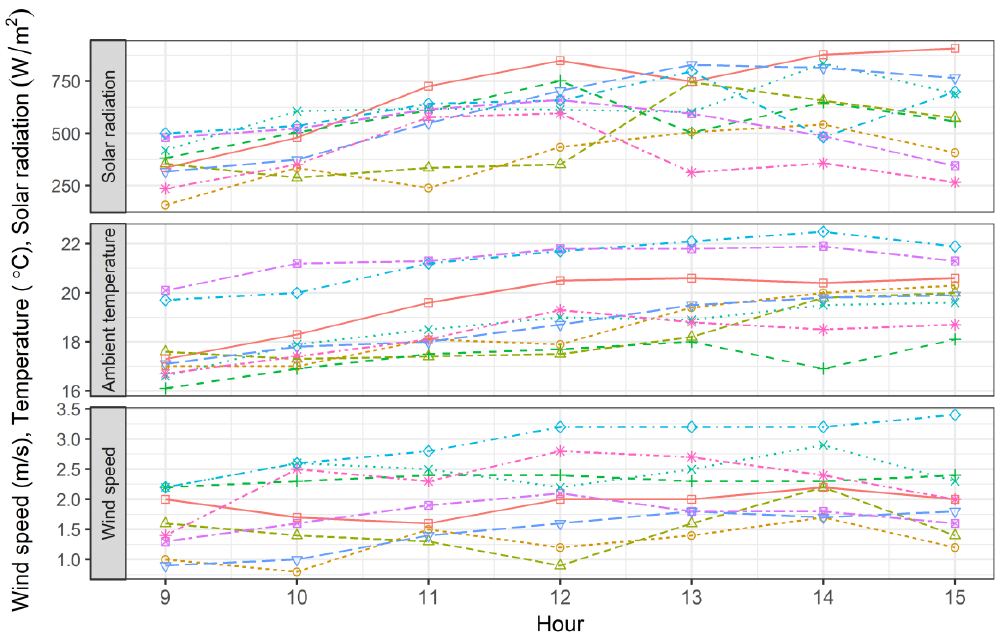
Figure 4. Hourly levels of the global horizontal solar radiation, ambient temperature and wind speed on each test day.